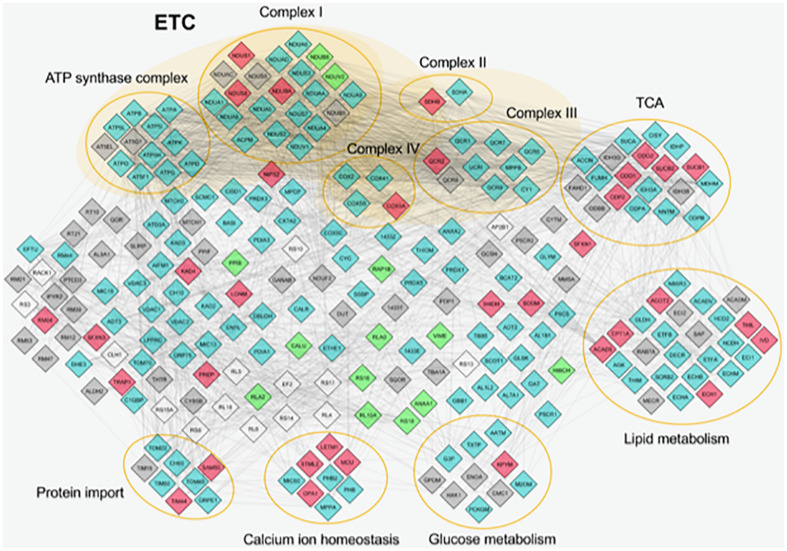
Protein–protein interactions of mitochondrial proteins identified by proteome analysis. The nodes represent individual proteins; the edges (lines) represent all cross-links identified among proteins. The nodes are colored in different ways on the basis of their abundance. Light blue, proteins expressed in similar way between control and Pseudoxanthoma elasticum (PXE); red, common proteins more expressed in PXE; green, common proteins more expressed in control; gray, unique proteins in PXE; white, unique proteins in control. Proteins without connections are excluded. ETC, electron transport chain; TCA, tricarboxylic acid cycle.